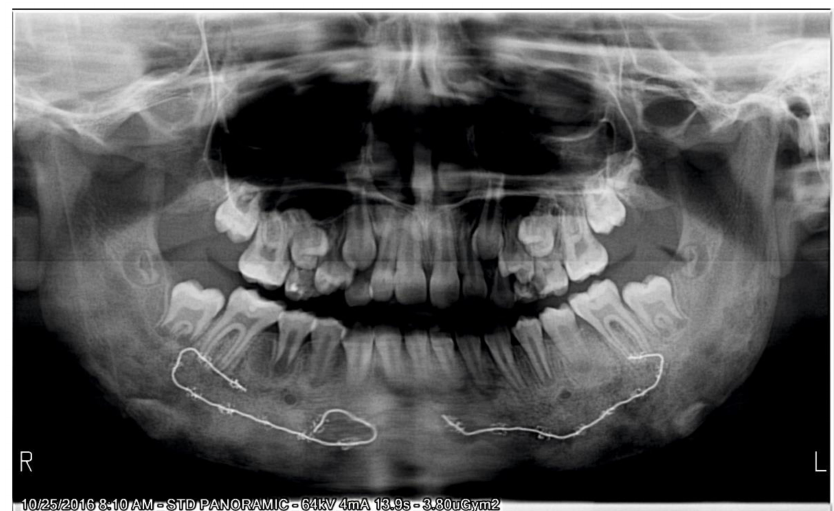
Figure 15. Post-splint therapy evaluation—panoramic radiograph. The cephalometric analysis (Figure 16) revealed an articular angle in the normal range, while all the other parameters remaining the same. Additionally, the natural curvature of the cervical spine was re-established and the space between C0, C1 and C2 was restored.